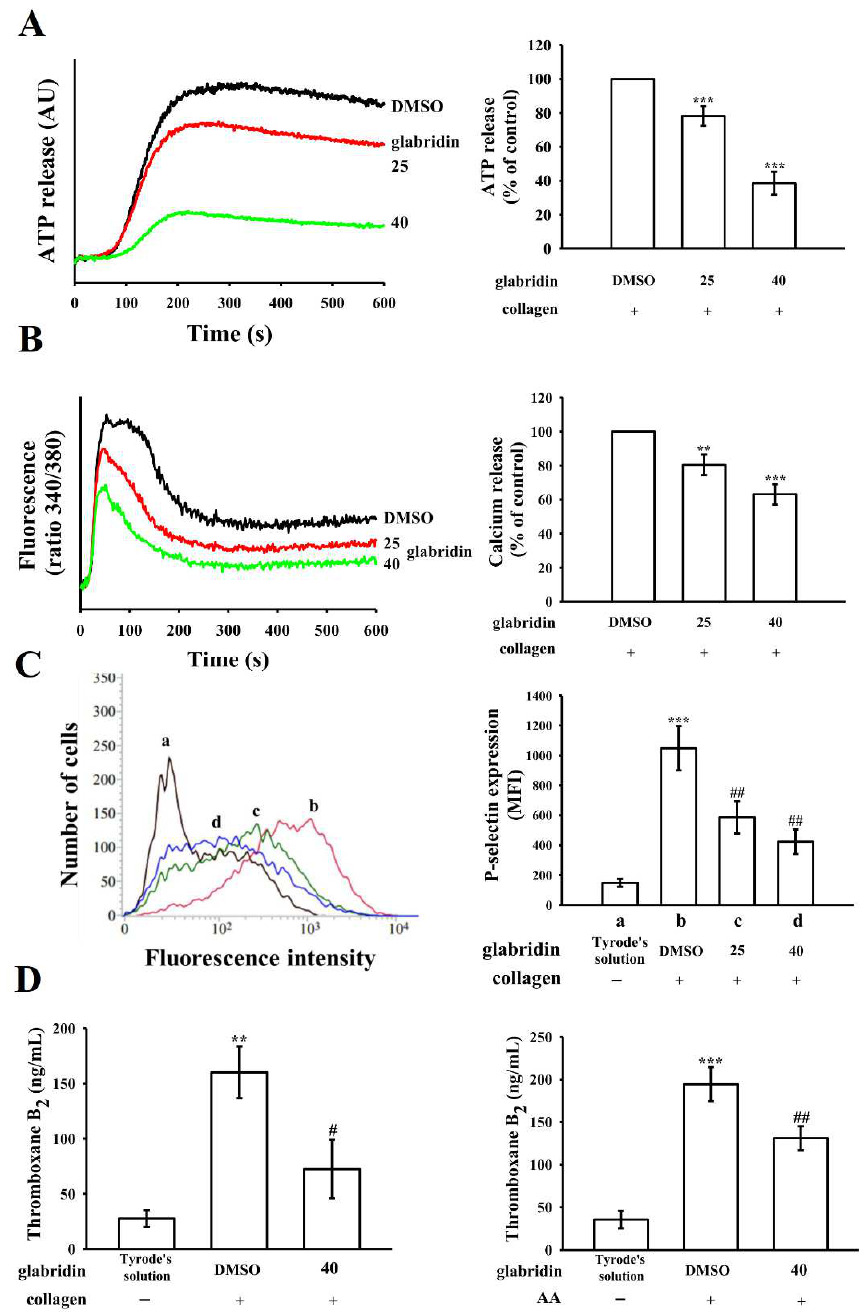
Figure 2. Inhibitory effects of glabridin on ATP release, relative [Ca 2+ ]i mobilization, P-selectin surface expression, and thromboxane B 2 formation in human platelets. Washed platelets (3.6 × 10 8 cells/mL) were preincubated with DMSO (0.1%) or glabridin (25 and 40 μM), followed by the addi- tion of collagen (1 μg/mL) or arachidonic acid (AA; 60 μM) to trigger ( A ) ATP release (arbitrary unit [AU]), ( B ) relative [Ca 2+ ]i mobilization, and ( C ) P-selectin surface expression (mean fluorescence intensity [MFI]) ((a) Tyrode’s solution, (b) collagen-stimulated platelets, (c) glabridin 25 μM, and (d) 40 μM). ( D ) Thromboxane B 2 (TxB 2 ) formation. Respective statistical analyses are indicated in the bar diagrams. Data are presented as the mean ± standard error of the mean (n = 4). ( A , B ) ** p < 0.01 and *** p < 0.001 vs. 0.1% DMSO + collagen group. ( C , D ) *** p < 0.001 vs. resting platelets (in Tyrode’s solution); # p < 0.05 and ## p < 0.01 vs. 0.1% DMSO + collagen group.